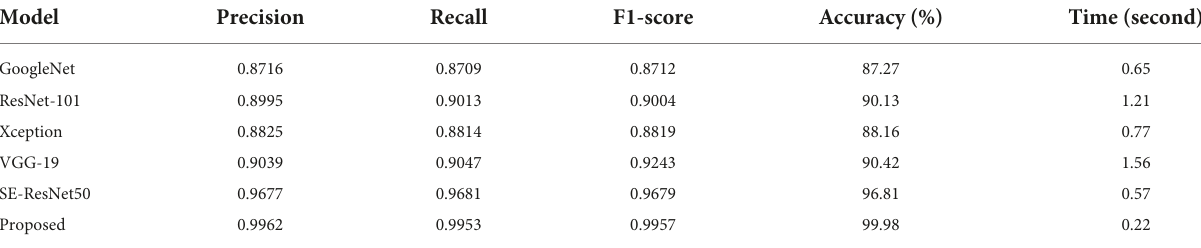
TABLE 3 Comparison with other DL frameworks.